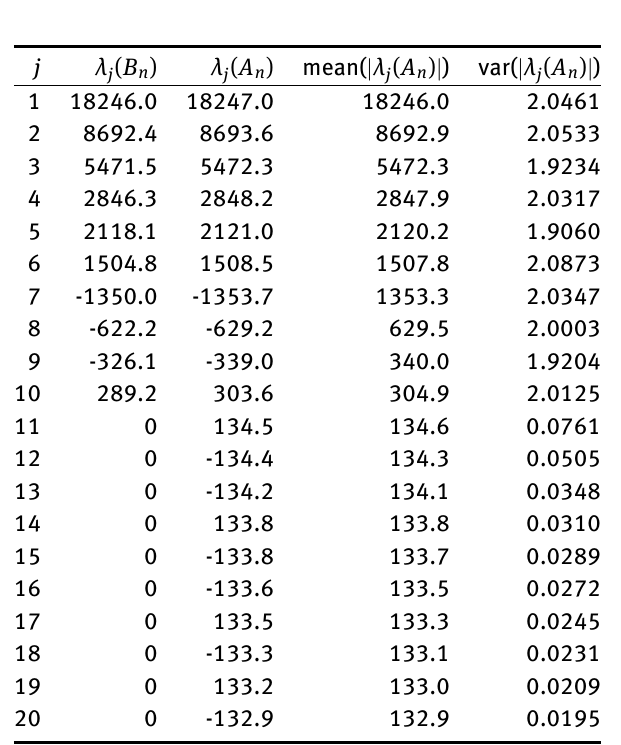
Figure 1: Left side: | λ 20 ( A n ) | < ··· < | λ 1 ( A n ) | ; right side: | λ 20 ( A n ) | < ··· < | λ 6 ( A n ) | in a typical realization in Example